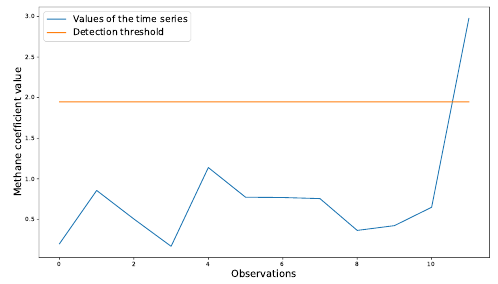
on several observations 4